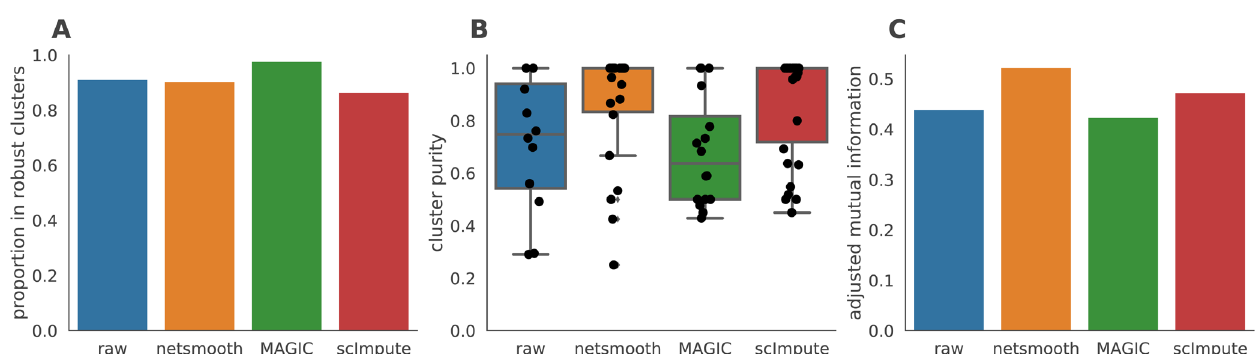
Figure 7. Imputation performance for the glioblastoma dataset. A ) The proportion of cells which were assigned to robust clusters. netSmooth , MAGIC, and scImpute all increased the proportion of cells that are assigned to robust clusters, with MAGIC leading, netSmooth in second place, and scImpute in third. B ) cluster purity (proportion of dominant cell type) for the robust clusters. netSmooth produces the most pure clusters in terms of tumor or cell line of origin. C ) AMI of the clustering results obtained after application of each of the methods. The online version of this figure is interactive.